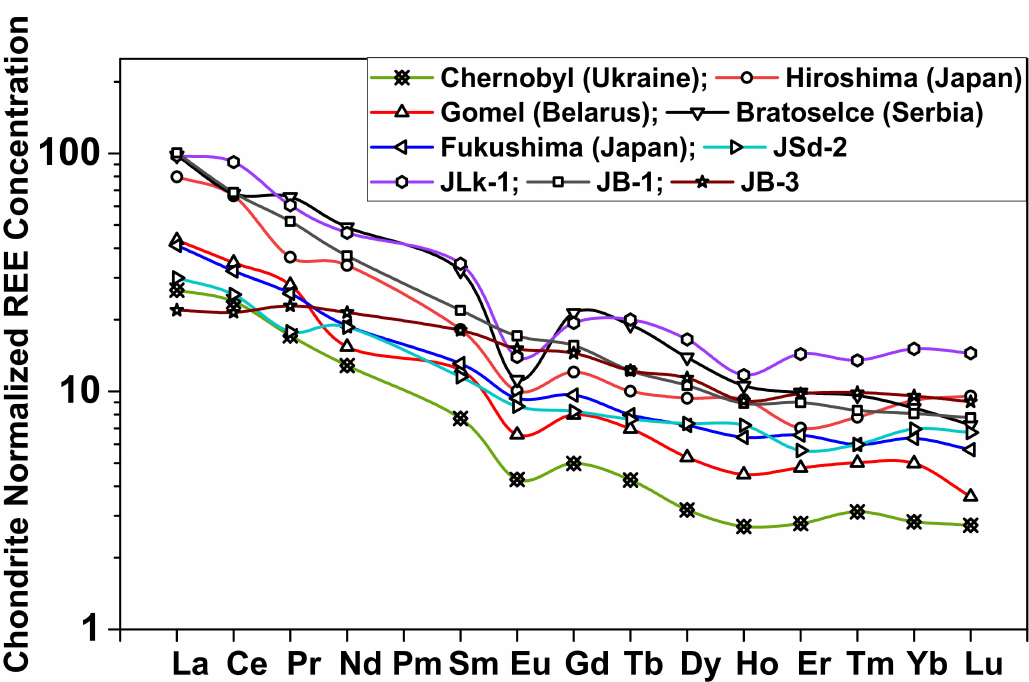
Figure 3. Chondrite-normalized REE patterns of four CRMs and five di ff erent soils. Ukraine and Belarus are situated on the Baltic and Ukrainian Shield of the east European